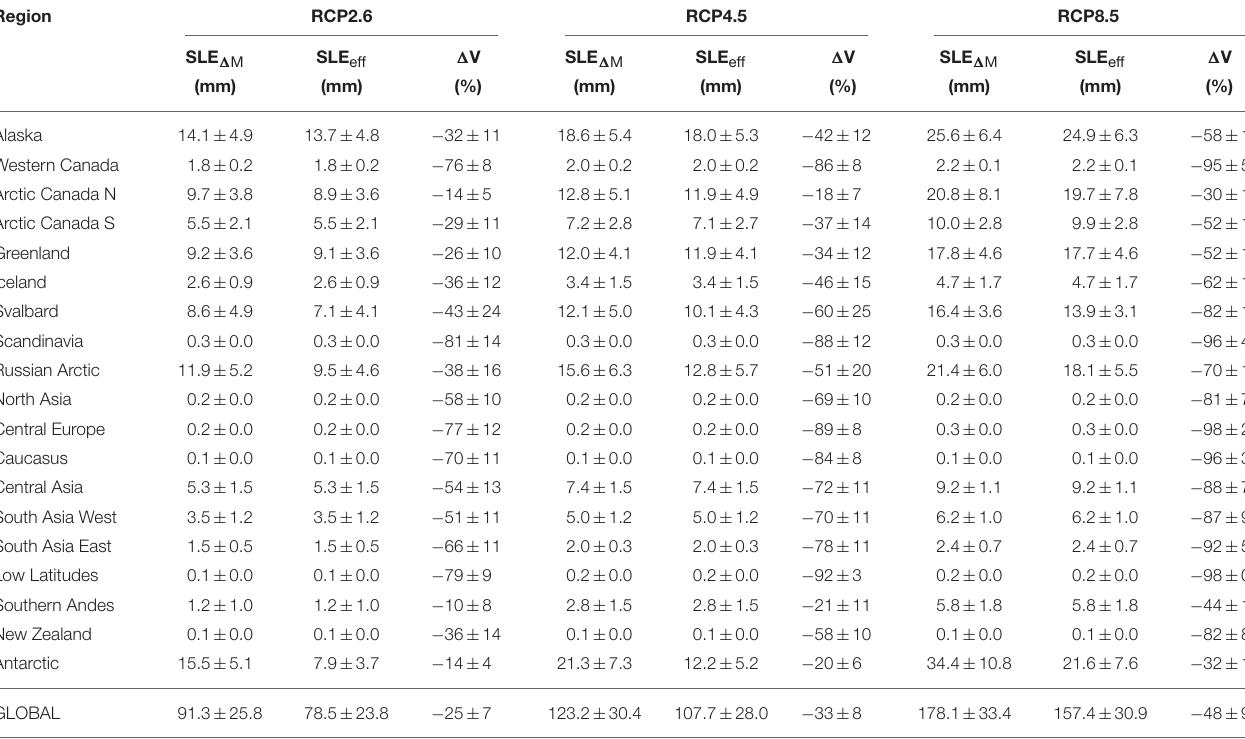
TABLE 2 | Regionally differentiated glacier mass loss in sea-level equivalent (SLE 1 M and SLE eff ), and glacier volume change 1 V for the period 2010–2100 (multi-model mean ± 1 σ ). Region RCP2.6